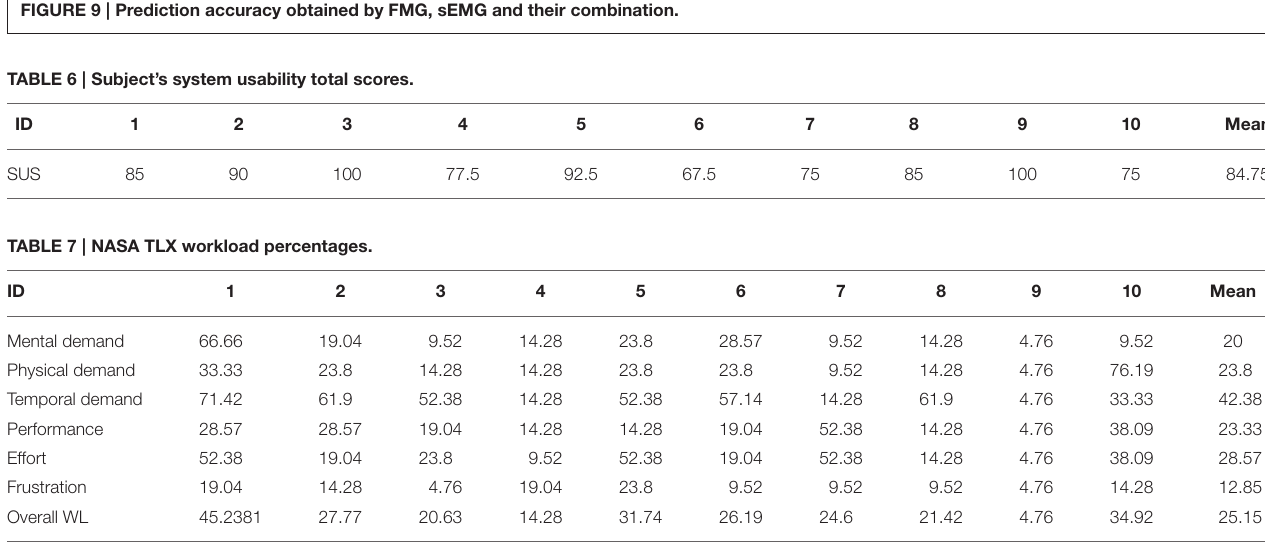
FIGURE 9 | Prediction accuracy obtained by FMG, sEMG and their combination.